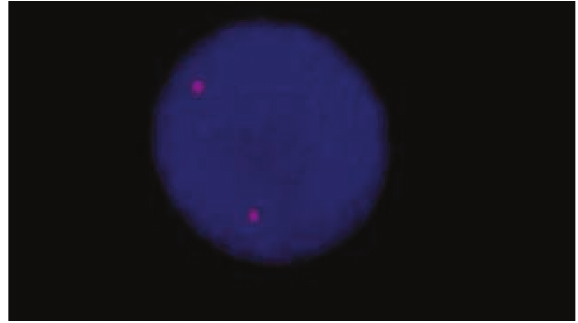
Figure 2: FISH analysis of interphase lymphocyte from the patient with DNA probes of CepX/Y.